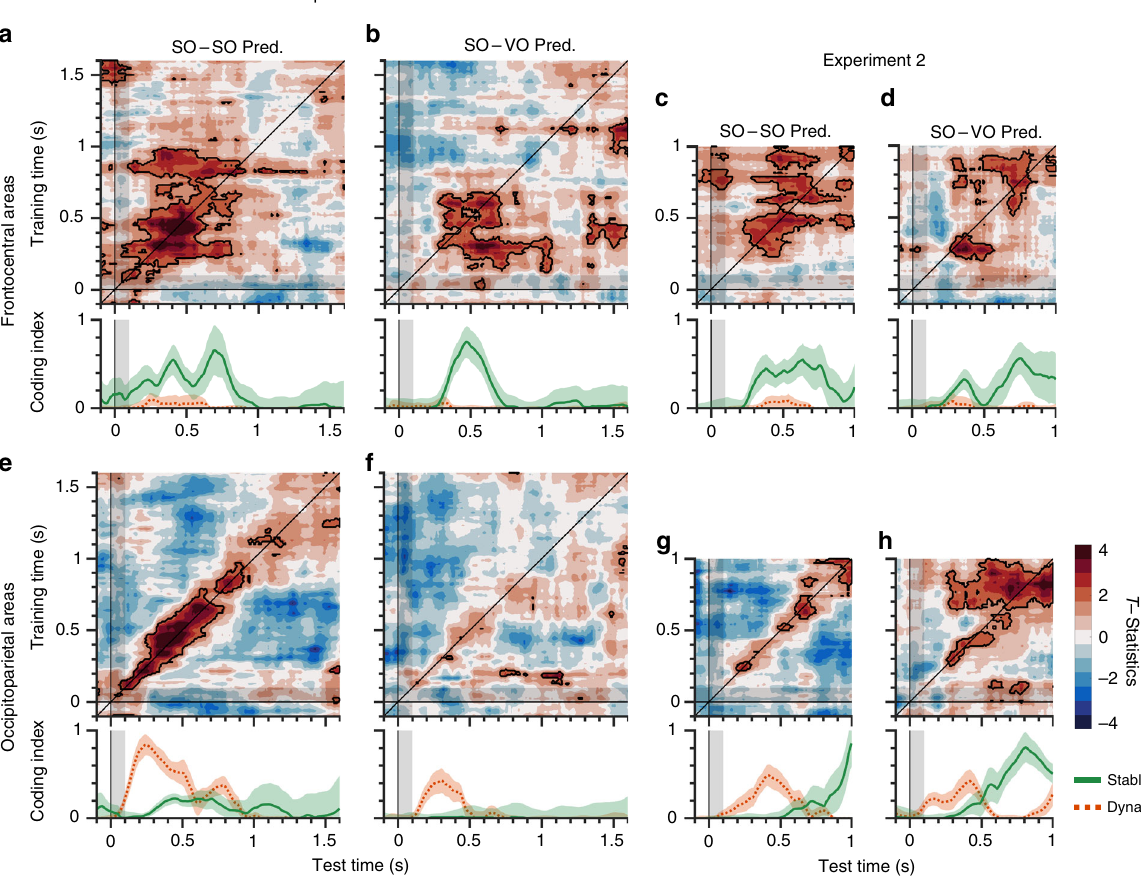
Fig. 6 Frontocentral areas showed stable coding, while occipitoparietal areas showed stable and dynamic coding in a task-dependent manner. a – d Results of frontocentral areas. a SO – SO temporal generalization from Experiment 1. b SO – VO temporal generalization from Experiment 1. c SO – SO temporal generalization from Experiment 2. d SO – VO temporal generalization from Experiment 2. e – h Results of occipitoparietal areas. e SO – SO temporal generalization from Experiment 1. f SO – VO temporal generalization from Experiment 1. g SO – SO temporal generalization from Experiment 2. h SO – VO temporal generalization from Experiment 2. Top, the x - and y -axes show the time of test and training sets after stimulus onset, respectively. Colors represent the t -statistics. Black areas show signi fi cant modulation over time, determined by a one-sided Monte Carlo randomization test, p < 0.05. Bottom, the x -axis shows the time after stimulus onset. The y -axis shows the magnitude of stable and dynamic coding. Green lines show stable coding. Red dotted lines show dynamic coding. Shaded areas represent ± 1 bootstrapped standard error. SO same orientation, VO varied